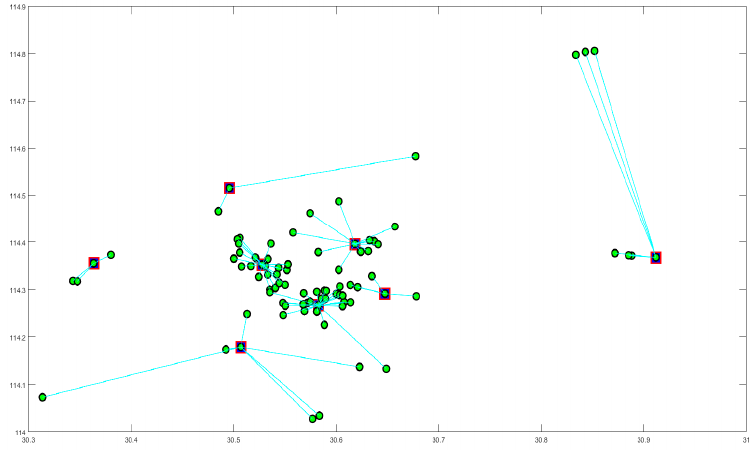
Figure 4. Screening transit points through the quantities of station in Wuhan. Table 3. Exclusion criteria for areas not suitable for the construction of medical waste disposal stations.